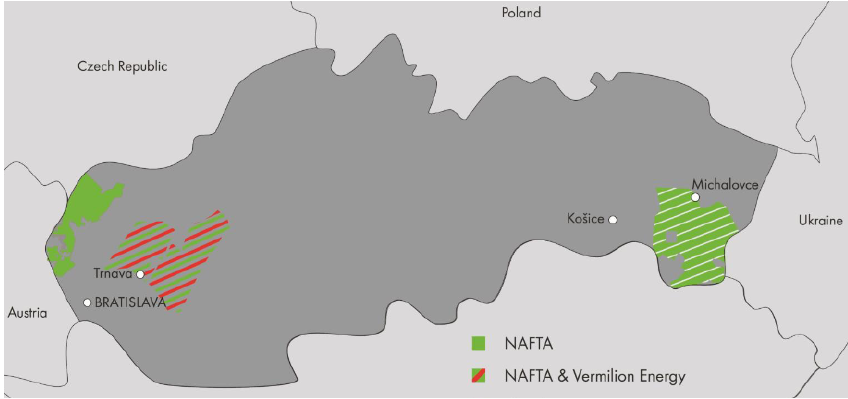
Figure 2. Exploration territories in the Slovak Republic [13].